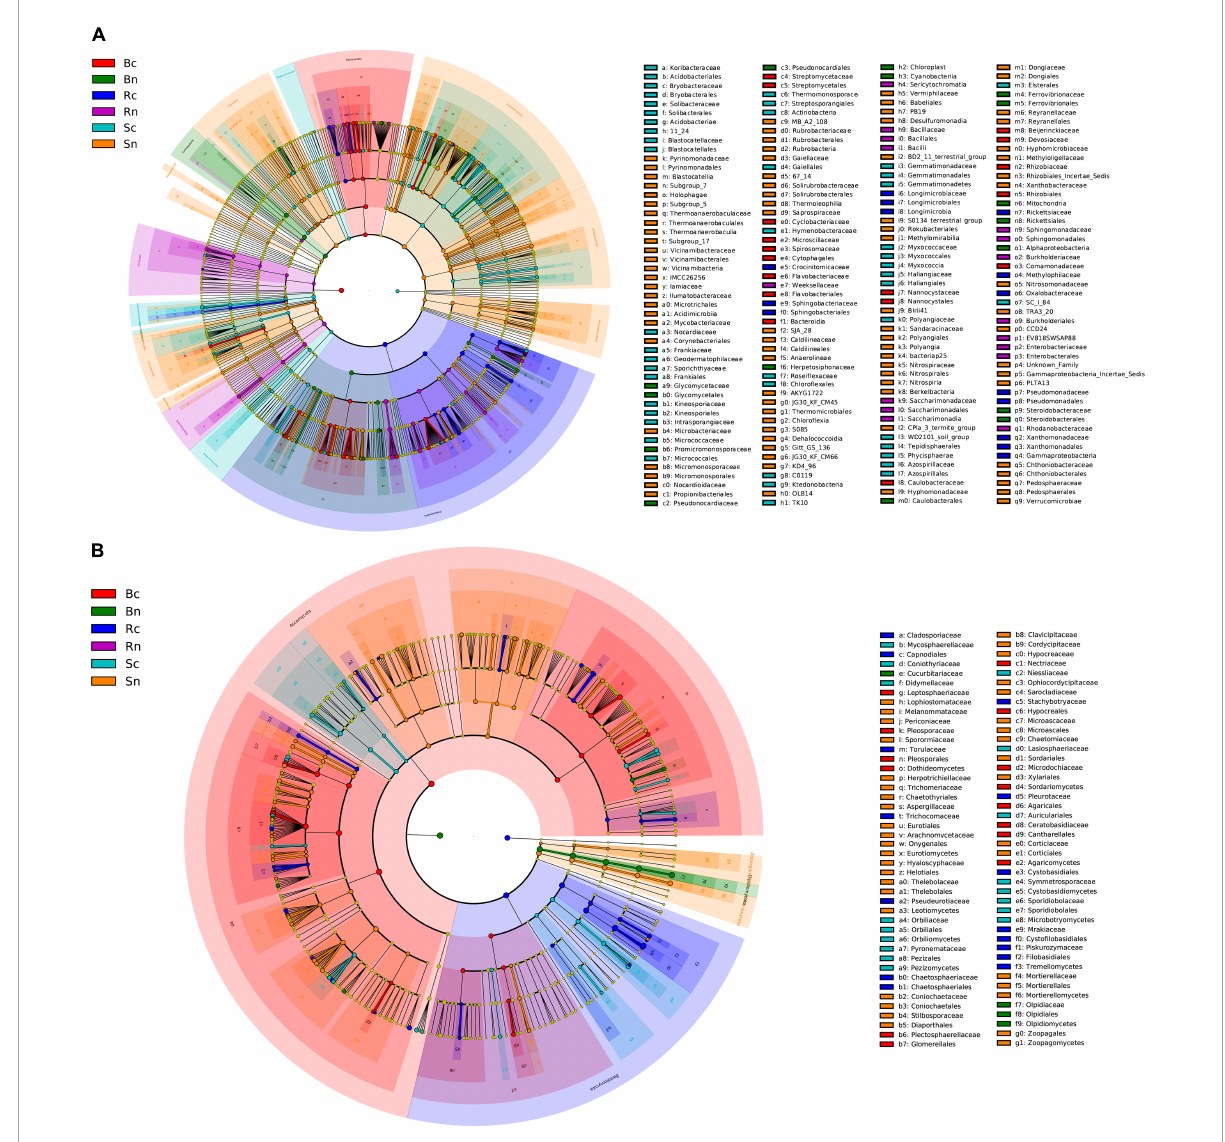
FIGURE5 Cladogram obtained from LEfSe analysis showing changes in different abundances of bacterial (A) and fungal (B) community at different taxonomic levels. The circles radiating from inside to outside represent the taxonomic level from phylum to genus. The different color nodes in the branches represent the microbial groups that play an important role in the color group. The species names represented by the English letters in Figure are displayed in the legend on the right. Sc, continuous cropping bulk soil; Sn, non-continuous cropping bulk soil; Rc, continuous cropping rhizosphere soil; Rn, non-continuous cropping rhizosphere soil; Bc, continuous cropping sugar beetroot; Bn, non-continuous cropping sugar beetroot.